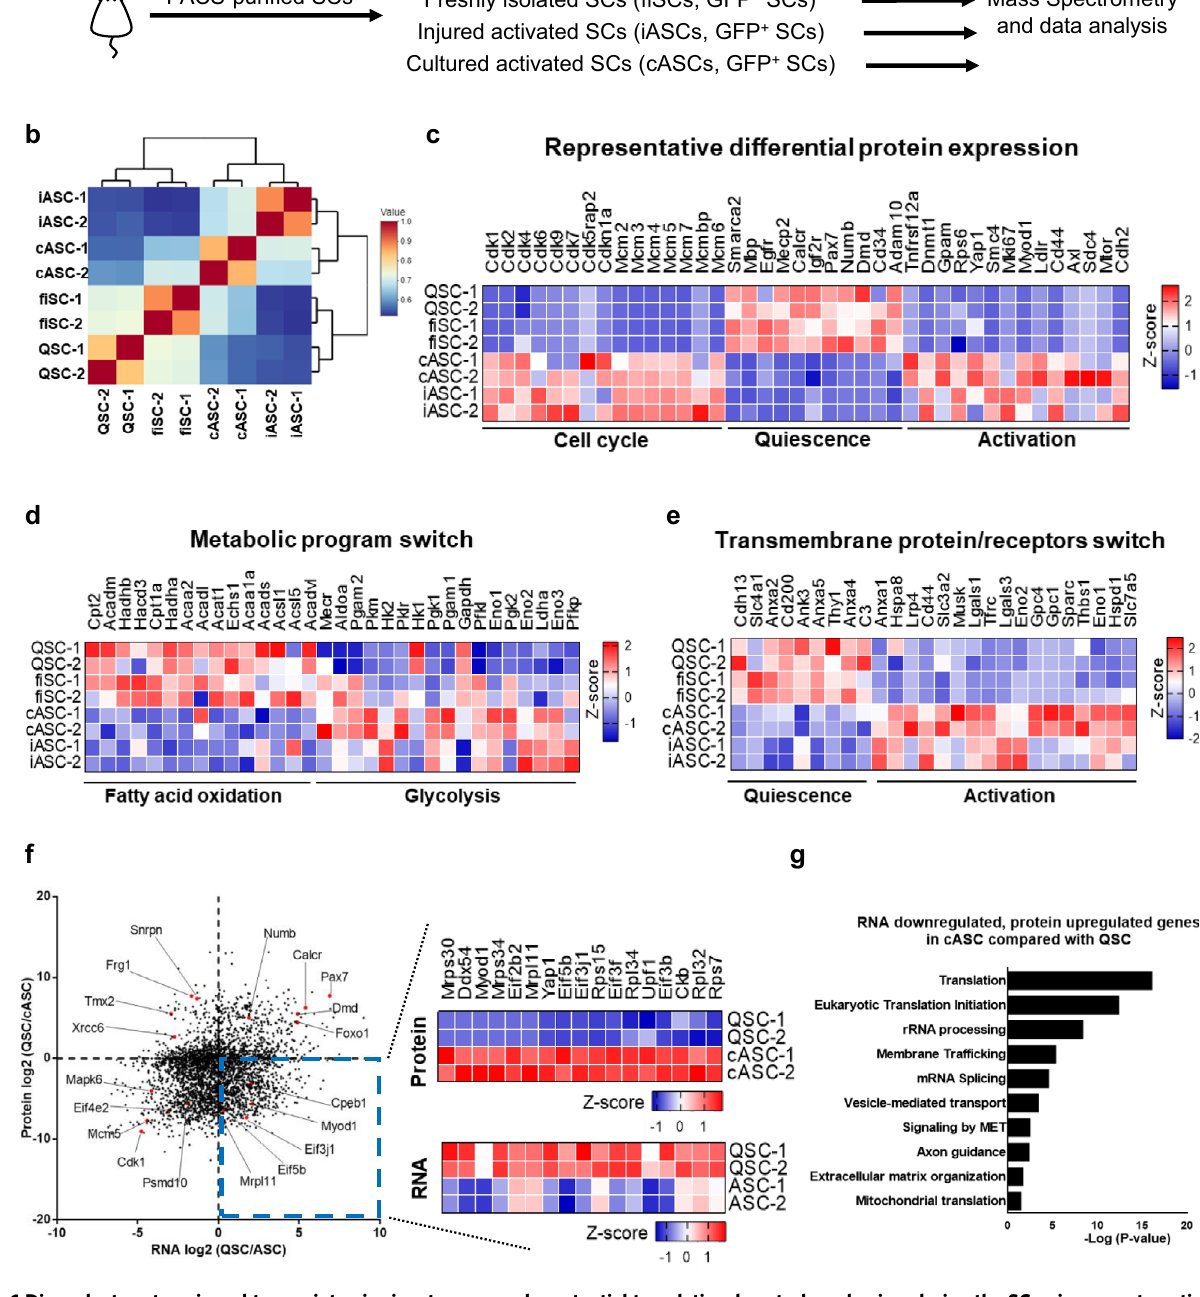
Fig. 1 Discordant proteomic and transcriptomic signatures reveal a potential translational control mechanism during the SC quiescence-to-activation transition. a Schematic illustration of the work fl ow for the proteomic analysis of FACS-isolated SCs. The SCs were sorted from Pax7-nGFP mice. QSCs were sorted from 0.5% PFA-perfused mice. fi SCs were sorted from unperfused mice. Injured ASCs (iASCs) were sorted from 3 days 1.2% BaCl 2 injured mice. Cultured ASCs (cASCs) were 2 days cultured SCs. ( n = 2 independent experiments). b Hierarchical clustering of the protein expression (in the number of spectra) for QSCs, fi SCs, iASCs, and cASCs. c Heatmap of representative expression for cell cycle, quiescence, and activation-speci fi c proteins of QSCs, fi SCs, iASCs, and cASCs. d Heatmap of representative expression for fatty acid oxidation and glycolysis-related proteins of QSCs, fi SCs, iASCs, and cASCs. e Heatmap of representative expression for transmembrane protein/receptors of QSCs, fi SCs, iASCs, and cASCs. f , g Analysis of transcriptome and proteome on QSCs and cASCs (proteome comparison) and iASCs (transcriptome comparison). f Scatter plot of the fold change of RNA and protein comparing QSCs to ASCs. Heatmap shows the RNA and protein expression of representative genes in the lower right quadrant of the scatter plot. g Functional enrichment analysis of genes from the lower right quadrant of f by g:Pro fi ler 99 . The g:Pro fi ler uses a hypergeometric test to measure the signi fi cance of functional terms in the input gene